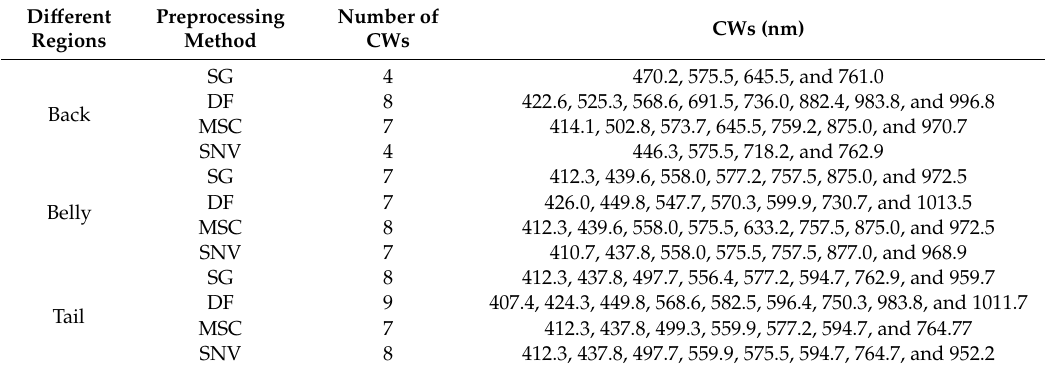
Table 3. CWs selected by RC.